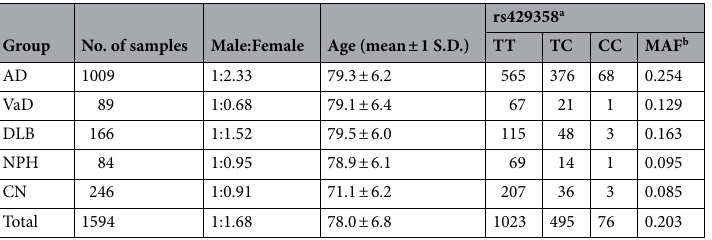
Table 1. Sample characteristics of each dementia subtype. a The C allele of rs429358 defines the APOE ε 4 phenotype, while the T allele defines wild-type, ε 3. b MAF Minor allele frequency.